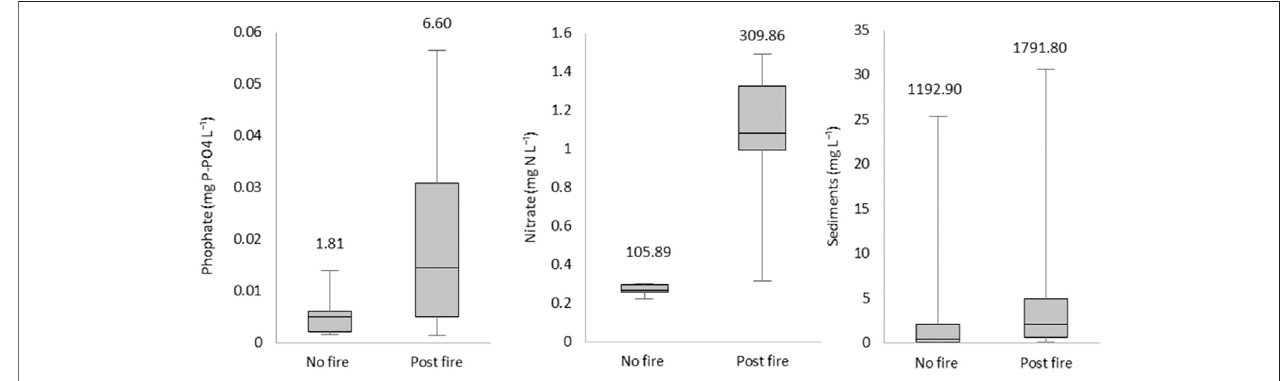
FIGURE8| Comparisonbetweenthescenariopost- fi reandthereferencescenariofortheyear1998.Thetotalconcentrationperliterispresentontopofeachbox-plot.